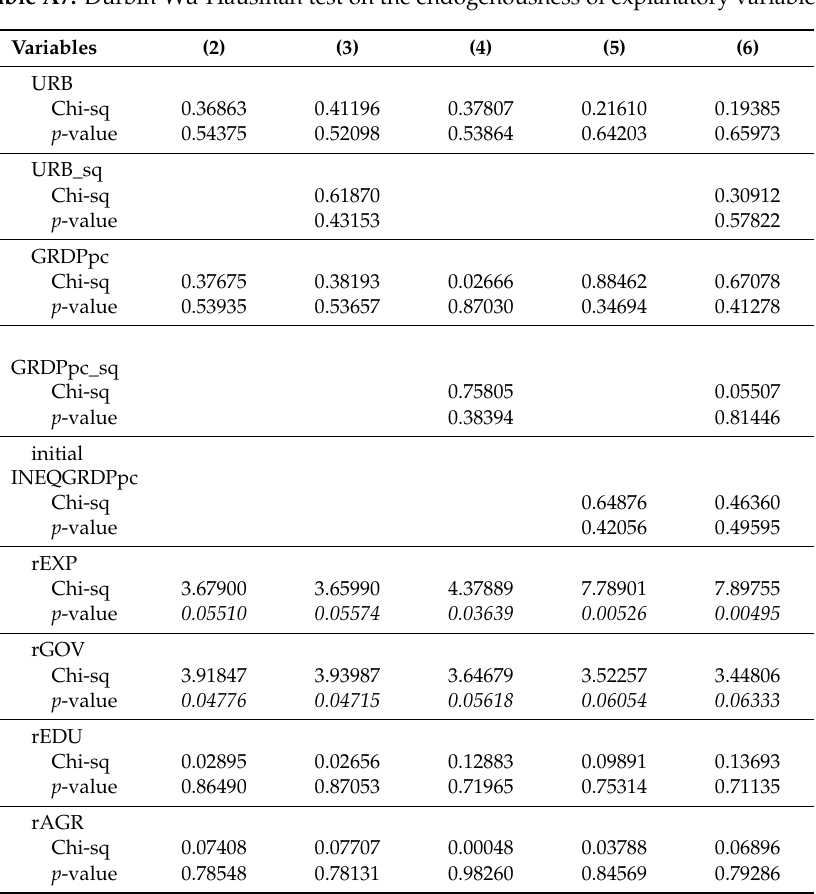
Table A7. Durbin-Wu-Hausman test on the endogenousness of explanatory